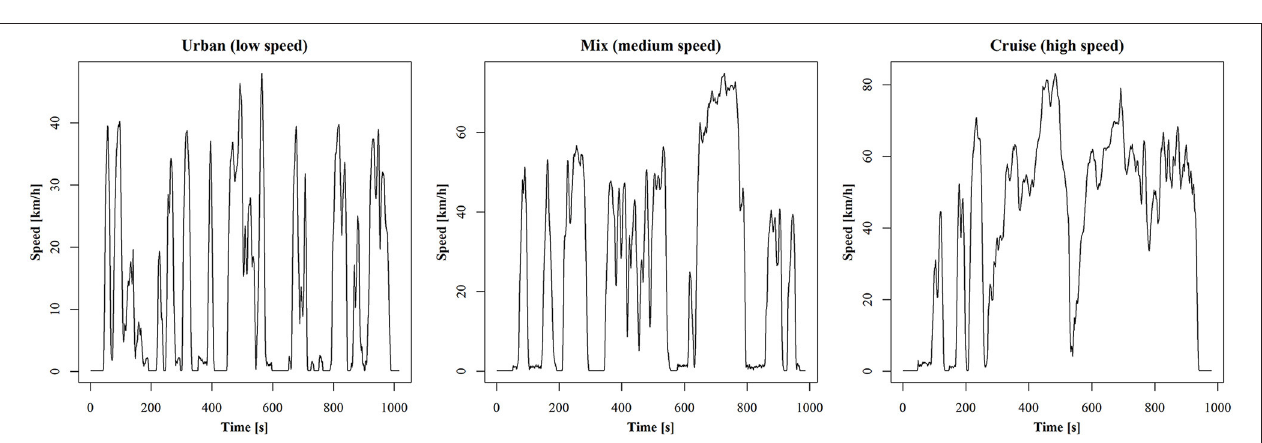
FIGURE 2 | Chassis dynamometer tests driving cycle patterns; urban (left), mix (middle), cruise